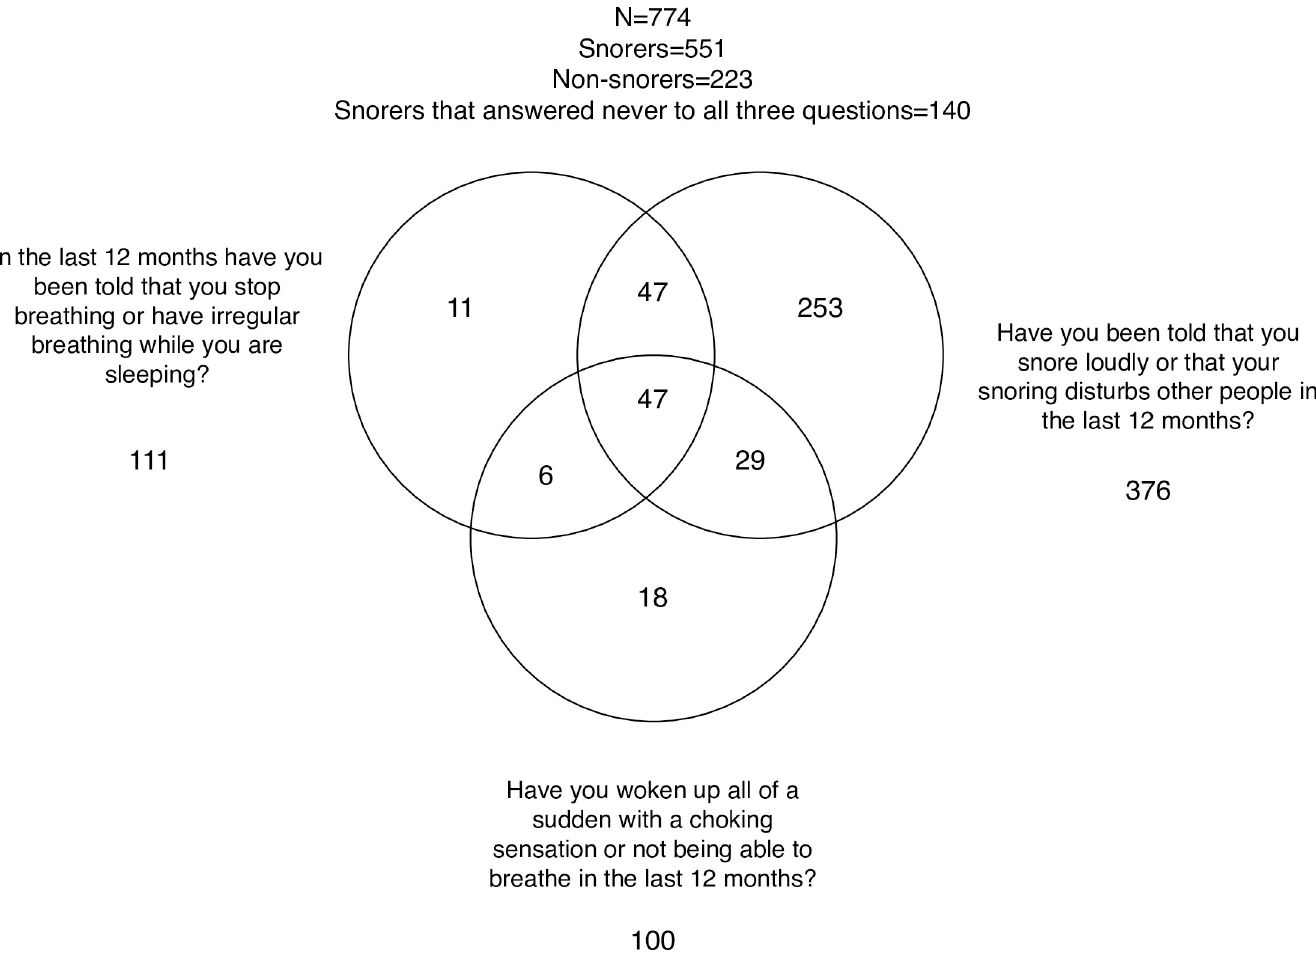
Among the included study population, a doubling of the concentrations of estrone and proges- terone in the bloodstream was associated with 19% respectively 9% decreased odds of snoring.